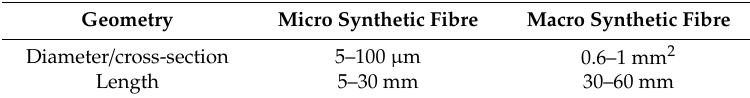
Table 1. Di ff erentiating micro synthetic fibres with macro synthetic fibres. (Adapted from Yin et al. 2015,